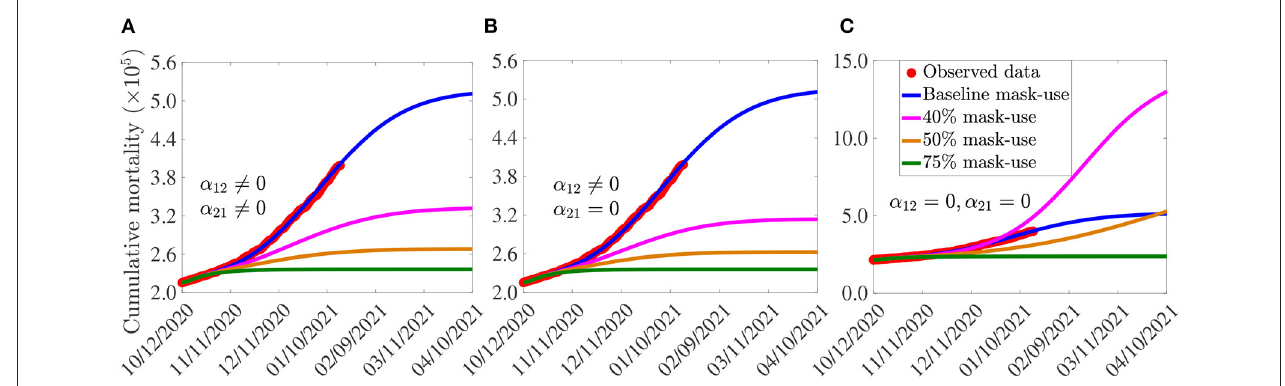
FIGURE 4 | Assessment of the impact of face mask usage, as a sole intervention, on COVID-19 pandemic in the U.S. Simulations of the model (2.5)–(2.6), showing cumulative mortality, as a function of time, for (A) face mask transition parameters ( α 12 and α 21 ) maintained at their baseline values, (B) mask-wearers strictly adhere to wearing masks ( α 21 = 0) and non-mask-wearers transit to mask wearing at their baseline rate ( α 12 6= 0), and (C) non-mask wearers and mask-wearers do not change their behavior (i.e., α 12 = α 21 = 0). Mask use change is implemented in terms of changes in the initial size of the population of individuals who wear face masks (from the onset of simulations, on October 12, 2020). Blue curves (in each of the plots) represent the baseline scenarios where the initial size of the population of mask wearers is fixed at 30 % , and the transition parameters, α 12 and α 21 , are maintained at their baseline values. Parameter values used in the simulations are as given by the baseline values in Tables 3 , 4 , with different values of α 12 and α 21 (except for the blue curves, where α 12 and α 21 are fixed at their baseline